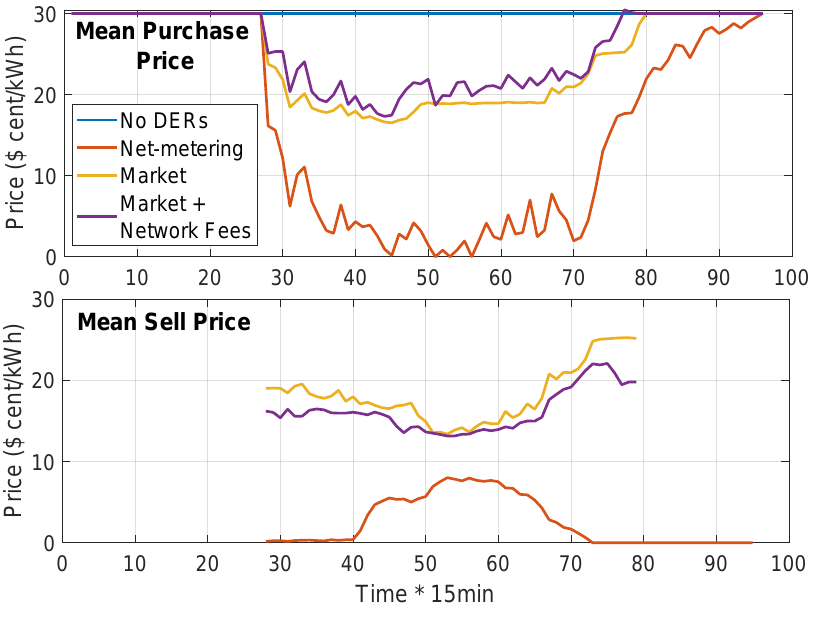
Figure 14. Mean purchase prices perceived by the prosumers at each market slot. Values are depicted in time in 15-min